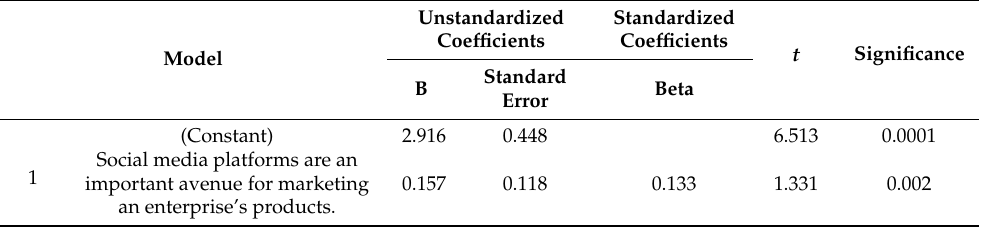
Table 4. The unstandardized and standardized coefficients for hypothesis H1.